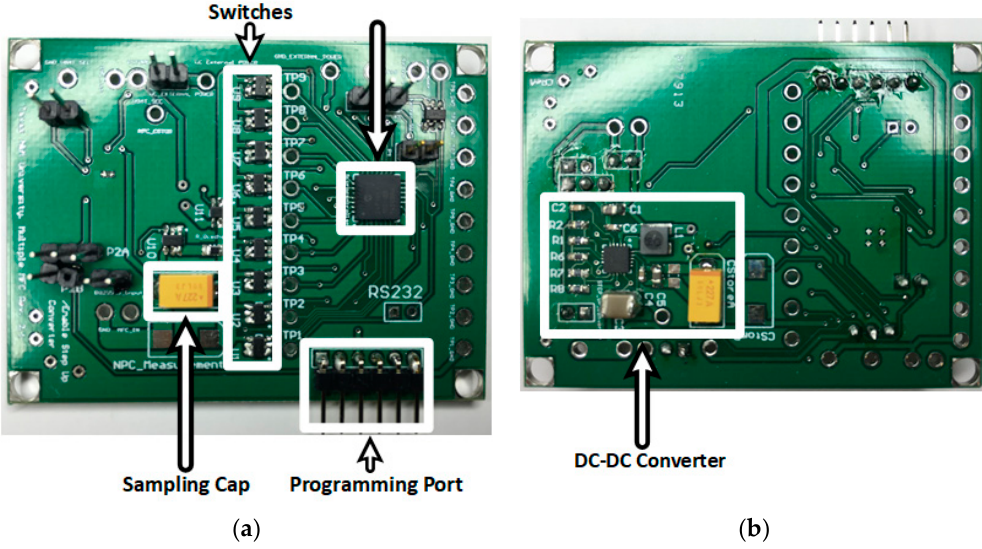
Figure 7. Printed Circuit Board of the PMS for multi-MFC power extraction, ( a ) top view; ( b ) bottom